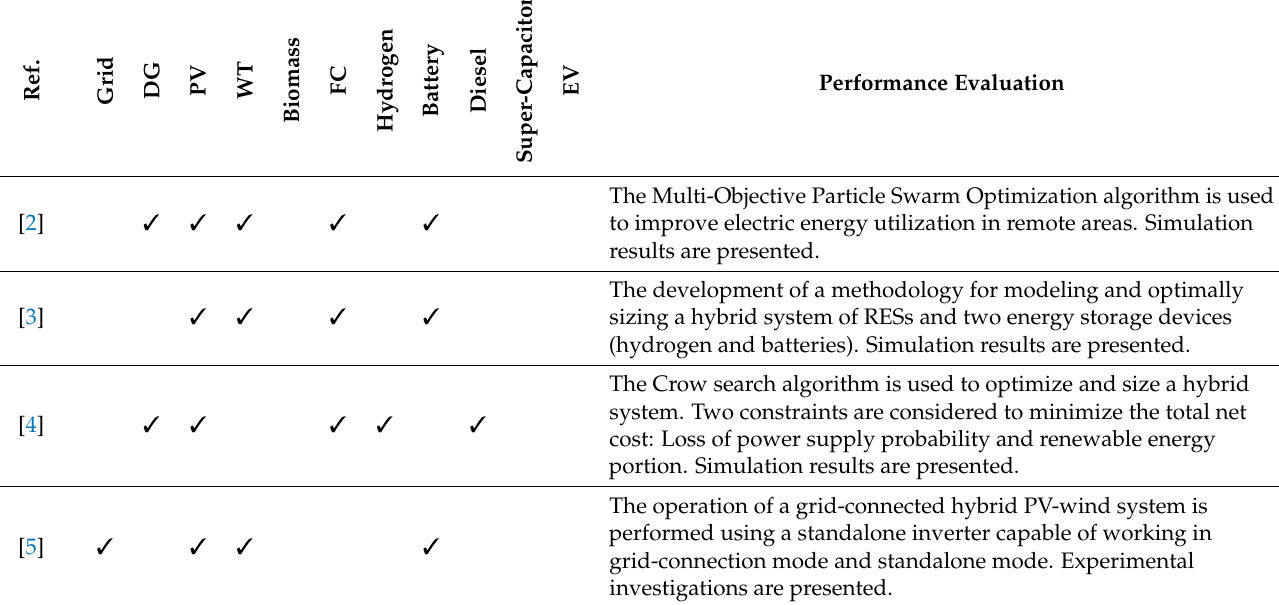
Table 1. Survey through collection of EM (energy management) for the hybrid MG (Micro-grid) system.